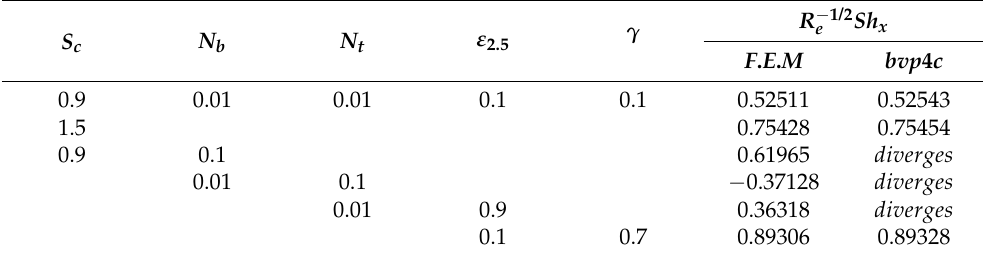
Table 5. List the numerical values for the local Sherwood number (excluding the Reynolds number) using M = 0.5, λ = 0.1, F r = 0.1, S c = 1.5, E 1 = 0.05, β = 0.5, ε 2 = 0.1, γ =